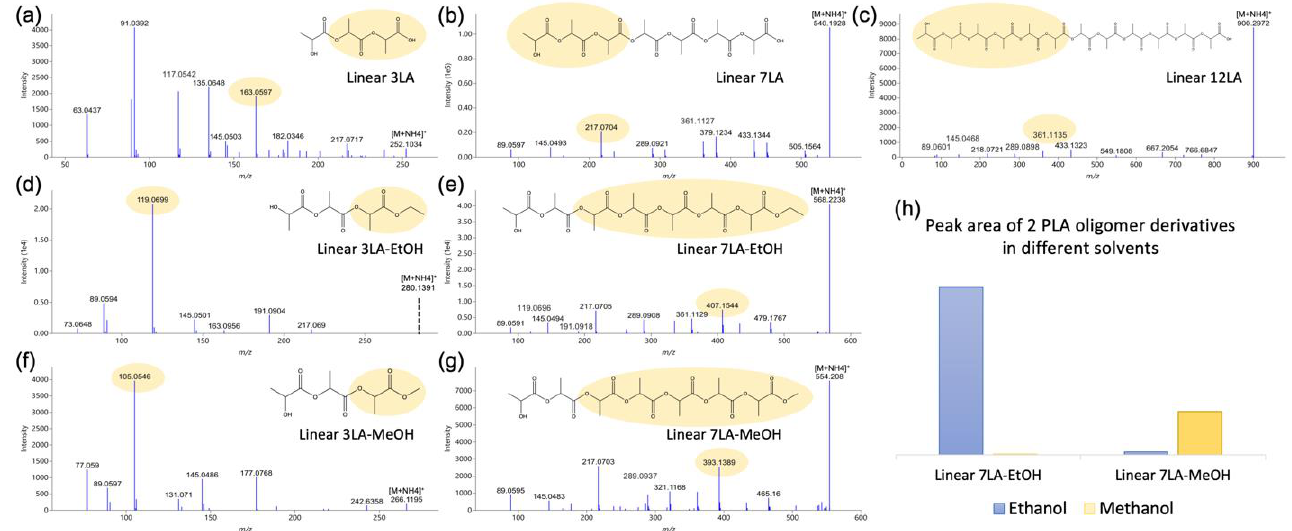
Figure 3. Spectra of linear PLA oligomers and their esterification products with ethanol and methanol. ( a ) Linear 3LA; ( b ) Linear 7LA; ( c ) Linear 12LA; ( d ) Linear 3LA-EtOH; ( e ) Linear 7LA-EtOH; ( f ) Linear 3LA-MeOH; ( g ) Linear 7LA-MeOH; ( h ) peak area of Linear 7LA-EtOH and Linear 7LA-MeOH in extracts with ethanol and methanol as